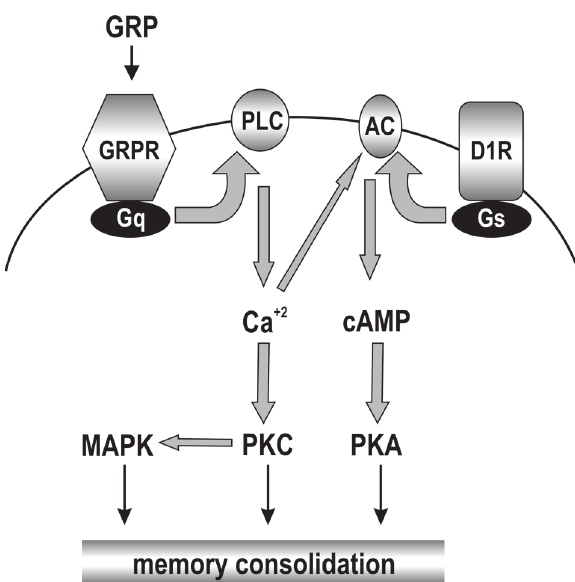
Figure. Proposed signaling pathways associated with the gastrin- releasing peptide receptor (GRPR) in the central nervous system. Gastrin-releasing peptide (GRP) released from synaptic terminals binds to the G protein-coupled GRPR at postsynaptic sites. GRPR q activation induces an increase in [Ca 2+ ] and triggers activation of the phospholipase C (PLC)/protein kinase C (PKC) pathway, which, in turn, can activate mitogen-activated protein kinase (MAPK). The protein (G ) and dopamine D1/D5 receptor (D1R) is coupled to G s s adenylyl cyclase (AC) activation. The D1R-induced cAMP signal might be synergistically potentiated by [Ca 2+ ]-induced stimulation of [Ca 2+ ]-responsive types of AC, leading to increased activation of protein kinase A (PKA). Reproduced from [16], with